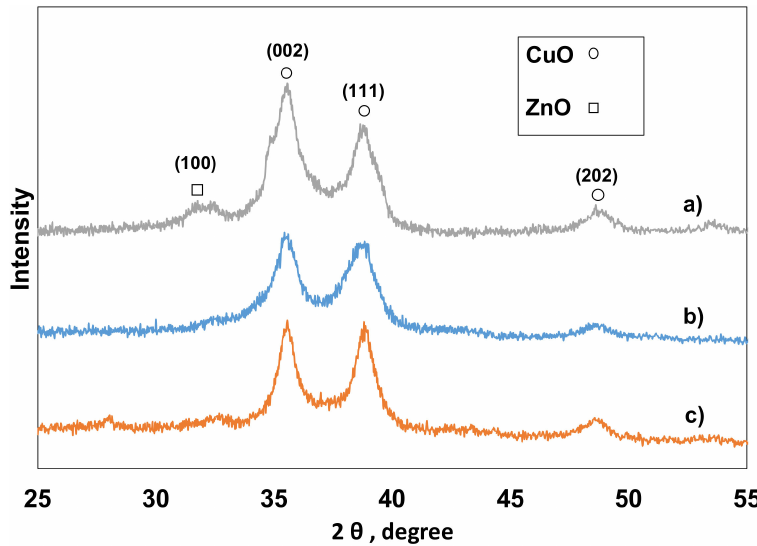
Figure 2. XRD patterns of calcined catalysts: ( a ) Cu/ZnO/Al 2 O 3 : Cu/Zn/Al (molar) = 35/35/30; ( b )